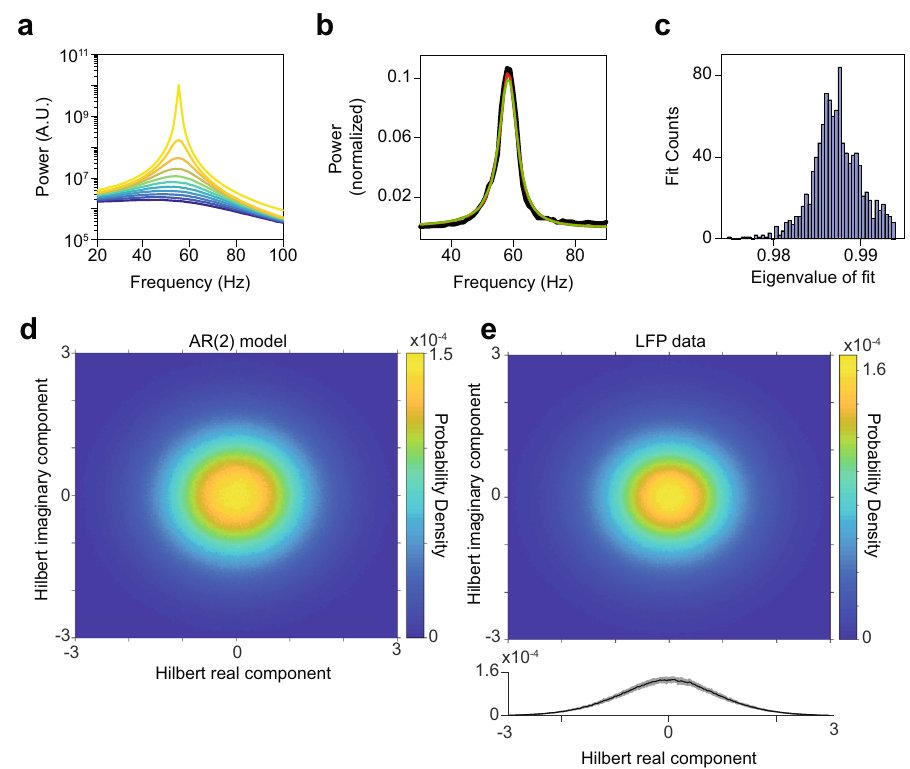
Fig. 8 AR(2) models fi t to LFP data. a Power spectra of synthetic signals generated from AR(2) processes with corresponding eigenvalue magnitudes ranging from 0.9 (dark blue) to 0.999 (bright yellow). Note that we used a periodogram with a rectangular taper, in order to minimize the spectral leakage around the peak; this can introduce an amount of broad-band leakage. b Black: the change in LFP power relative to baseline as a function of frequency (Hz), for an example site in monkey T during the presentation of a full-screen drifting grating. Red: power spectrum of a synthetic signal generated by an AR(2) model. The AR(2) model was fi tted to the LFP spectrum shown in black (see Methods section). Green: power spectrum of the I component of a linear PING model which is equivalent to the AR(2) model. c Histogram of eigenvalue magnitudes corresponding to AR(2) model fi ts of the LFP data. d Phase-plane of AR(2) data with eigenvalue magnitude of 0.99. Data were Hilbert-transformed. Shown are the imaginary and real component of the Hilbert-transform and their relative density. The imaginary and real component were z -scored to allow for averaging across channels. e Same as d but for LFP data. The LFP data were high-pass fi ltered above 10 Hz before being Hilbert-transformed. Shown below is the standard deviation across channels. Source data are provided in the Source Data fi